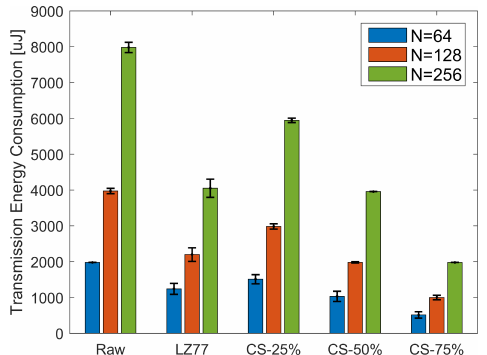
Figure 13. Average and standard deviation of TEC, over the total number of pressure blocks, for different compression types.